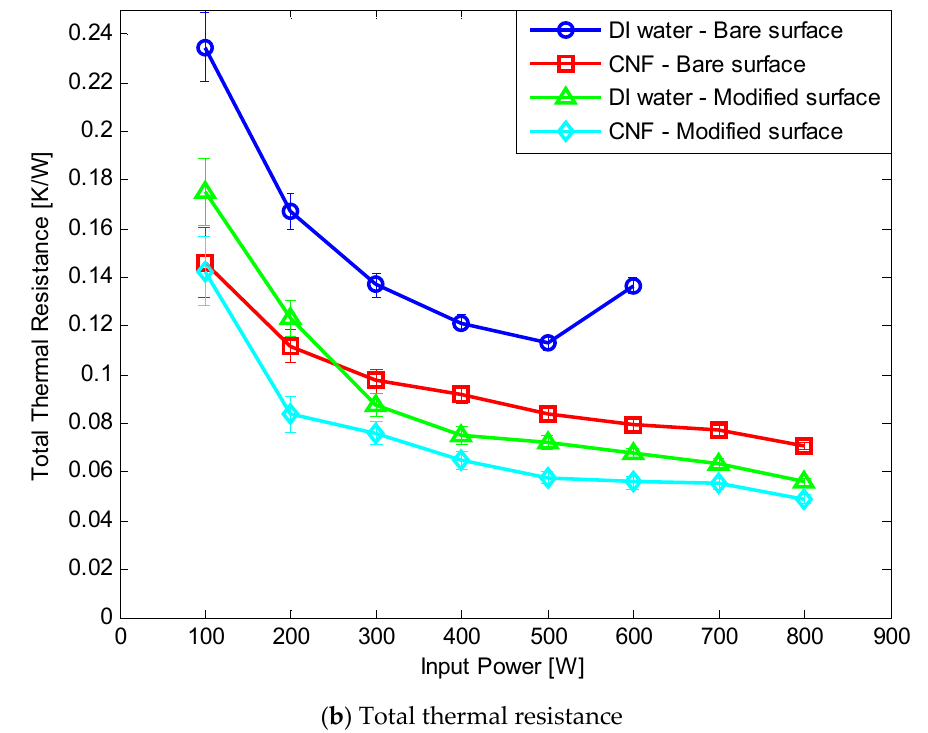
Figure 10. Comparison of experiment result at FR 0.25.